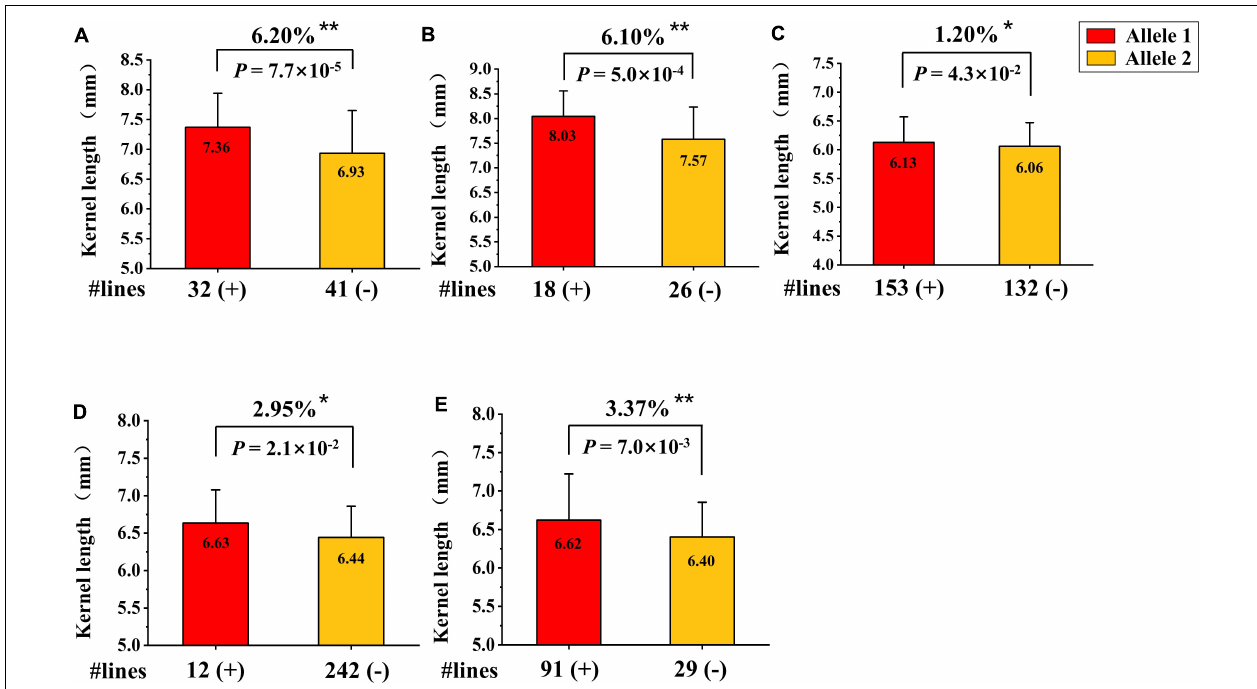
FIGURE 7 | Validation of QKL.sicau-2SY-1B in two different genetic populations and three variety panels. (A,B) Effects of QKL.sicau-2SY-1B in two validation populations of SSY (A) and MTL4SY (B) by fluorescence PCR typing results of the Kompetitive Allele Specific PCR (KASP) marker KASP- AX-109379070 , respectively. (C–E) Effects of QKL.sicau-2SY-1B based on the flanking marker AX-109379070 in 300 Chinese wheat cultivars (CWC), 272 Chinese wheat landraces (CWL), and 165 Sichuan wheat cultivars (SWC), respectively. Allele1 (+) and Allele2 (-) represent lines with and without the positive alleles of the target quantitative trait loci (QTL) based on the flanking marker. **Significance at the 0.01 probability level; *significance at the 0.05 probability